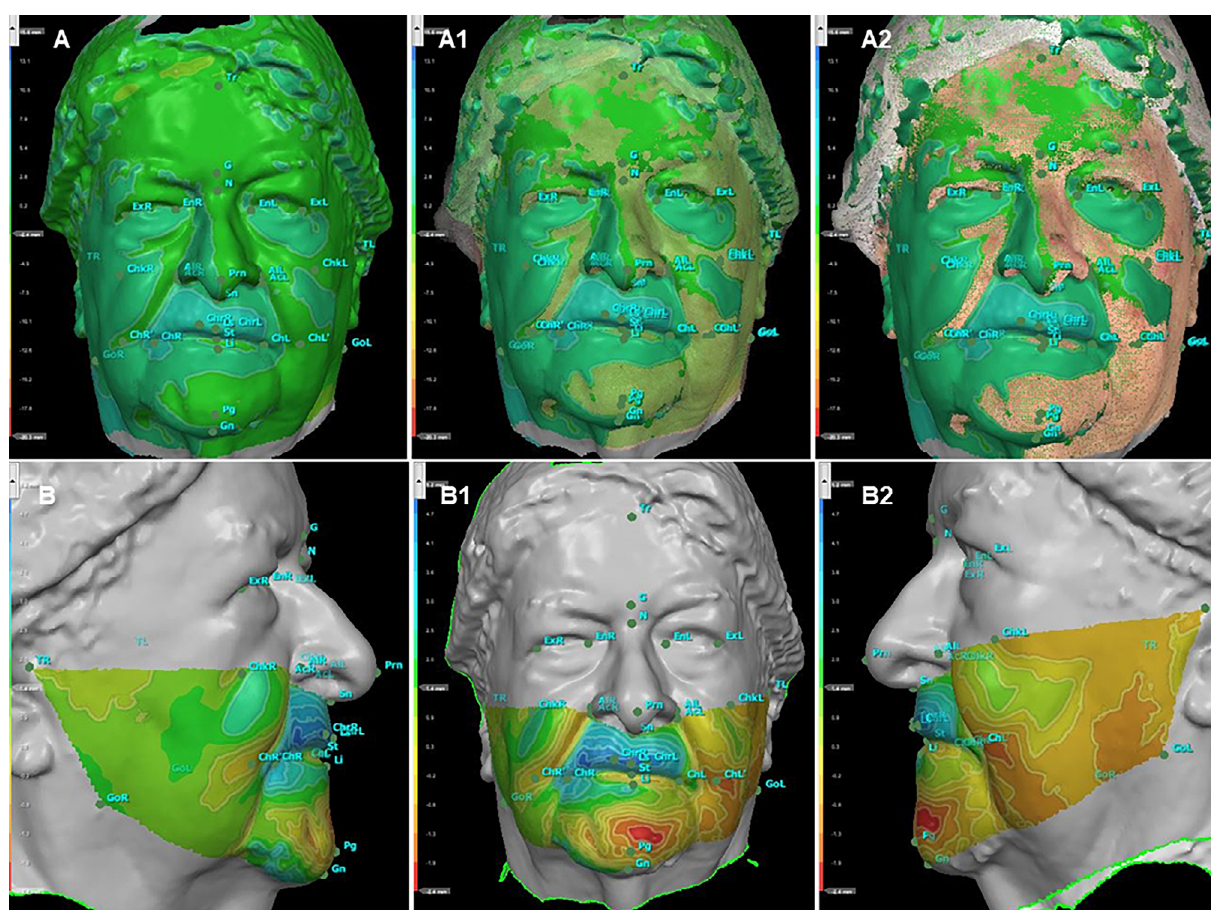
Figure 7- Steps of a chromatic facial analysis with different colors (red: areas with -1 mm to 0 mm difference, green: 0mm superimposed areas, and blue: areas with 0 to 2 mm difference) between two scans (T1 and T2). Superimposed full face (A, A1, A2), and superimposed lower third face from the right (B), from the front (B1), and from the left (B2) Table 1- Comparative analysis of linear measures (mm) in two timestamps, T1: without complete dentures and T2: with conventional maxillary and mandibular complete dentures in all participants (n=30)